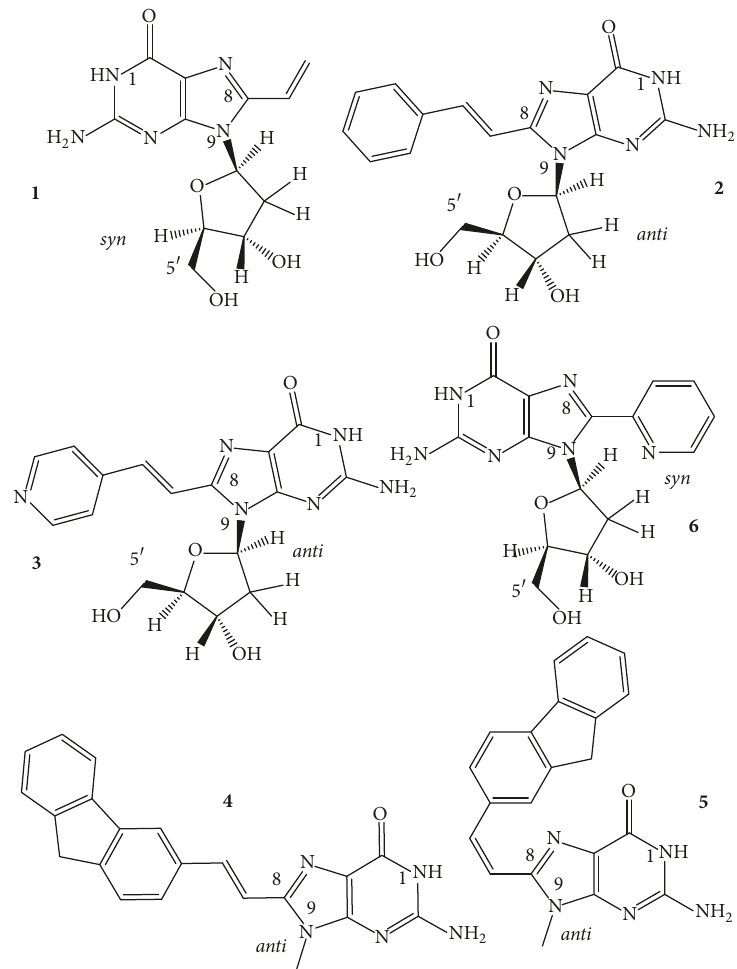
Figure 7: Structure of the syn 8-vinyl-2-deoxyguanosine ( 1 ); the anti 8-(2-phenylethenyl)- ( 2 ) and 8-[2-(pyrid-4-yl)-ethenyl]-dGs ( 3 ); the cis ( 4 ) and trans isomers ( 5 ) of the anti 8-vinyl-substituted-dGs; and the syn 8-(2-pyridyl)-dG ( 6 ).